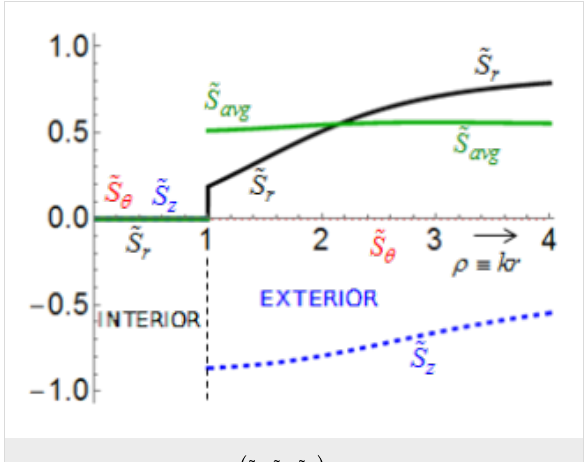
Figure 8: Spin components for the counter-rotational case plotted over 0 ≤ ρ ≡ kr ≤ 4 for m = 3, R ρ ≡ kR = 1, and q = (1 + i )/ √ 2. The scaled variable is , for